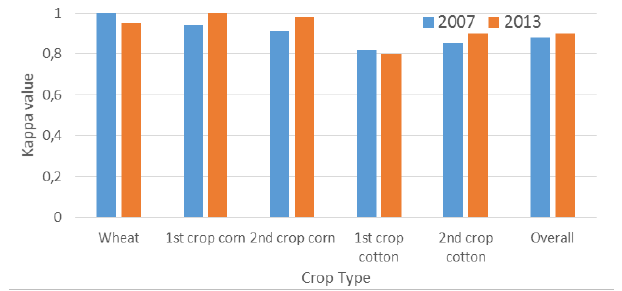
Figure 4. Kappa statistic results wheat, corn and cotton and